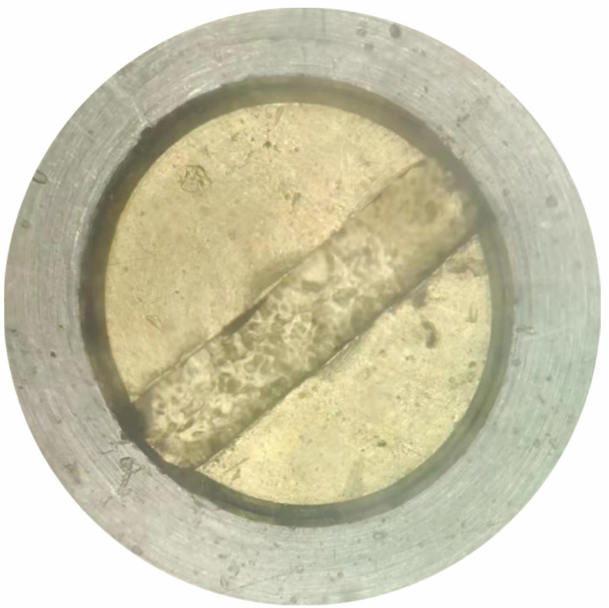
Figure 12. Conditions in the kettle before the experiment.